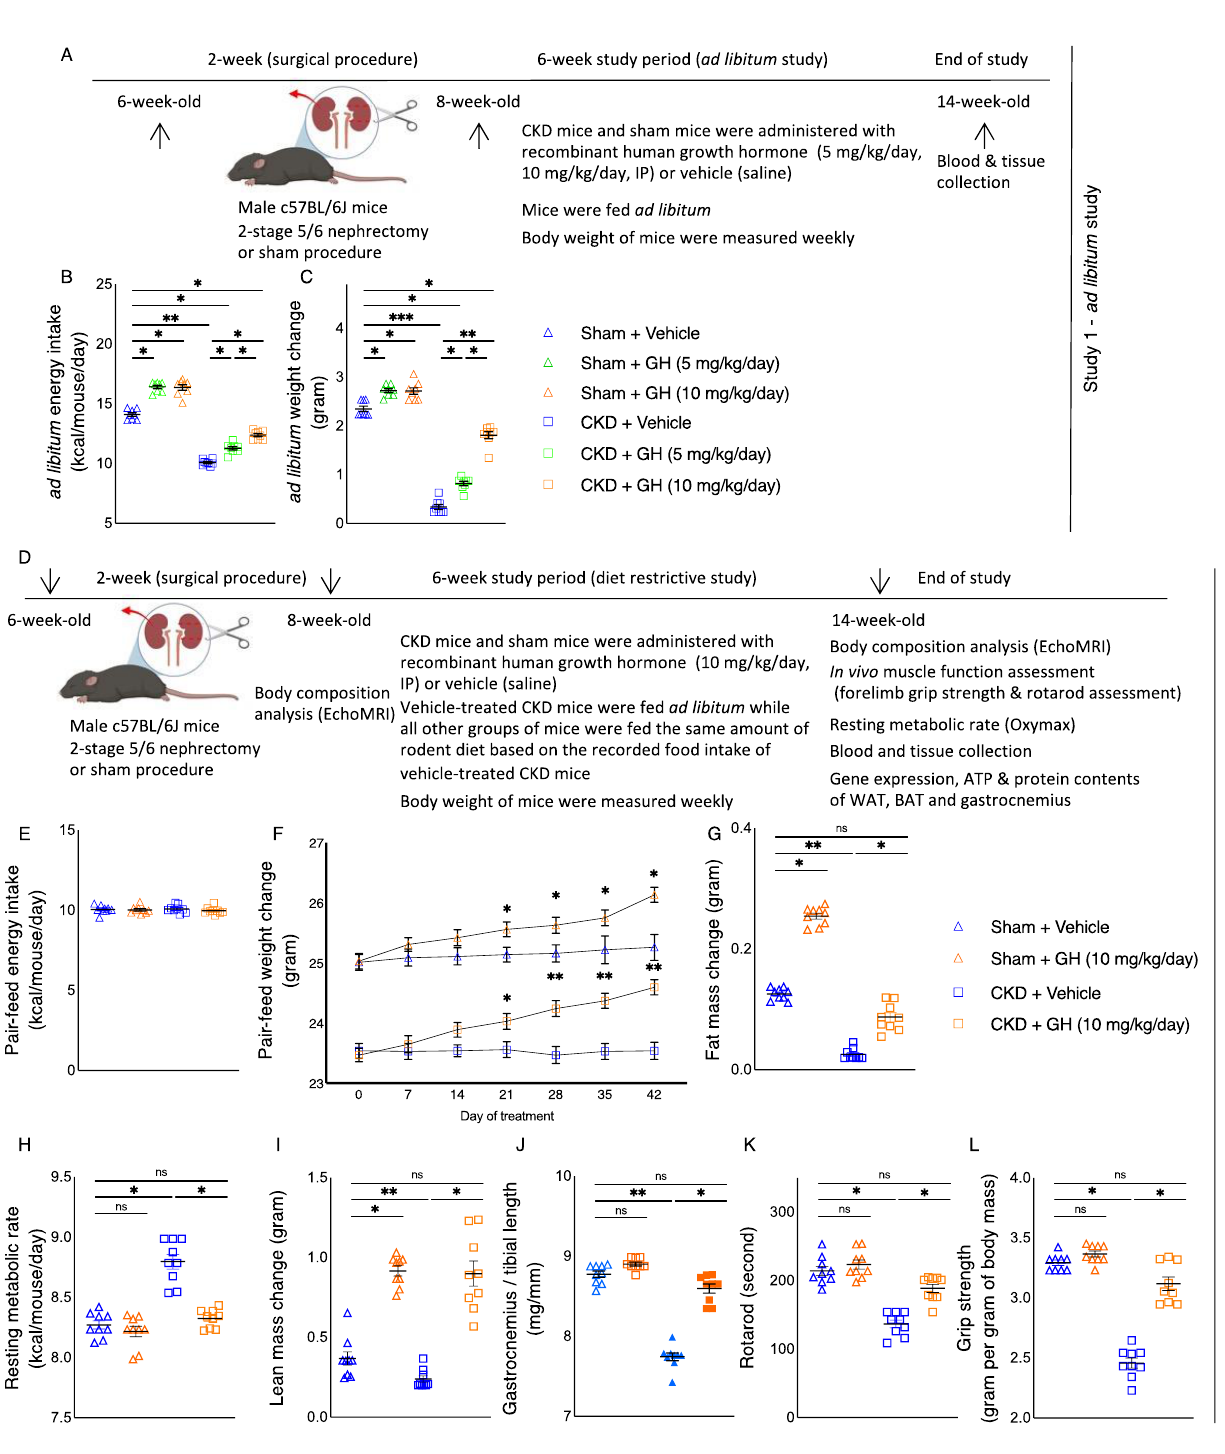
Figure 1. GH attenuates cachexia in CKD mice. We performed two studies. For the first study, we used ad libitum dietary strategy ( A ). CKD and control mice were given GH (5 mg/kg/day or 10 mg/kg/day), or vehicle (normal saline), respectively, for six weeks. All mice were fed ad libitum. We calculated average daily caloric intake ( B ) and recorded final weight change in mice ( C ). Results of Sham + GH (5 mg/kg/day) and Sham + GH (10 mg/kg/day) mice were compared to those of Sham + Vehicle mice, while results of CKD + GH (5 mg/kg/day) and CKD + GH (10 mg/kg/day) mice were compared to those of CKD + Vehicle mice. In addition, results of CKD + GH (5 mg/kg/day) mice were compared to those of CKD + GH (10 mg/kg/day) mice. Furthermore, results of CKD + Vehicle, CKD + GH (5 mg/kg/day), and CKD + GH (10 mg/kg/day) mice were compared to those of Sham +